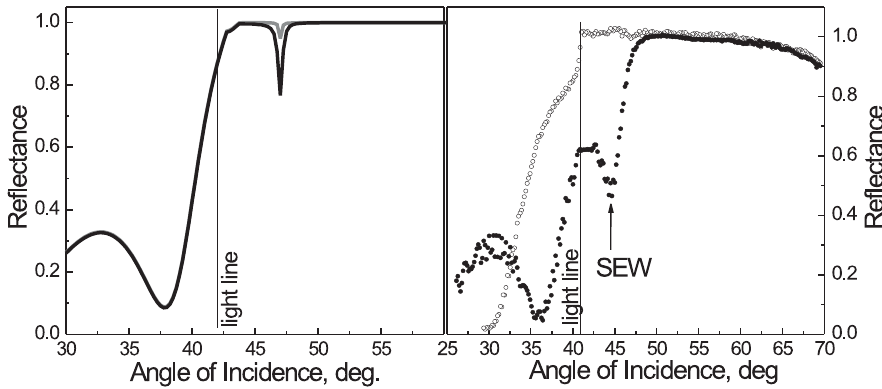
Figure 2. Calculated ( left panel ) and measured ( right panel ) fluorescence-induced visualization of BSW coupled using partial immersion. The calculated (gray line) and measured (open circles) reflectivity spectra of a bare photonic crystal demonstrate negligible resonance dip. The dip becomes more pronounced in calculated (black line) and measured (black circles) reflectivity spectra for the photonic crystal with Rhodamine 6G thin film at the surface. Reprinted with permission from I.V. Soboleva, E. Descrovi, L. Dominici, F. Michelotti, F. Giorgis, A.A. Fedyanin, Proceedings of SPIE